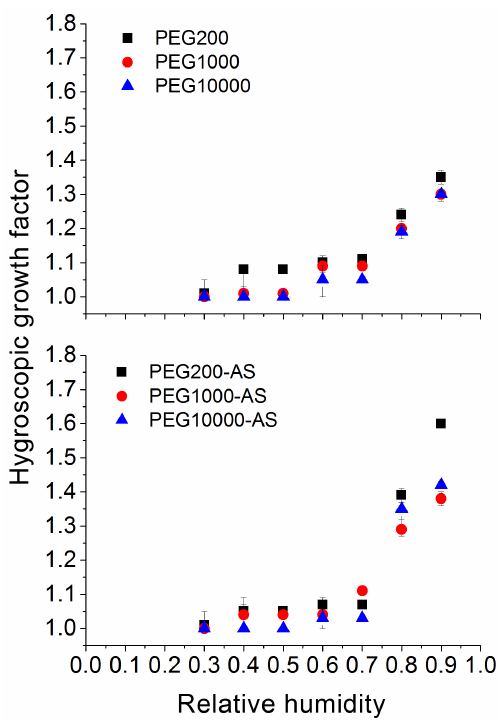
Figure 1. Measured hygroscopic growth factors (HGFs) for aerosol systems comprised only of PEG (top) and aerosol systems com- prised of PEG and ammonium sulfate (AS) with PEG:AS mass ratios of 2 : 1 (bottom). HGFs were measured for particles with di- ameters of 250nm. Symbols indicate the average HGF, and error bars indicate the maximum and minimum HGFs derived from re- peated measurements with the